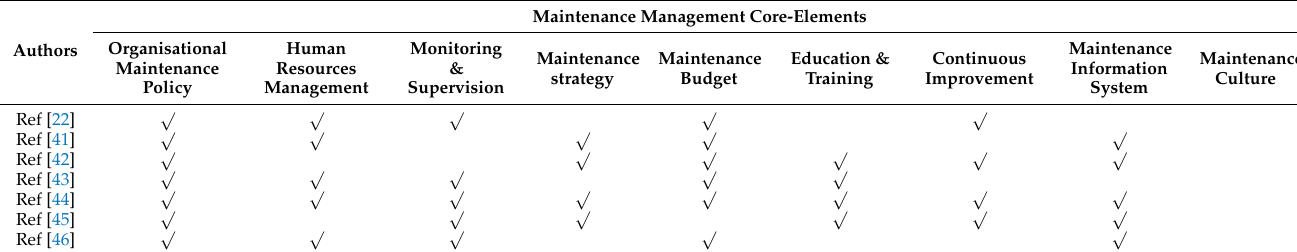
Table 1. Summary of the core elements from the models